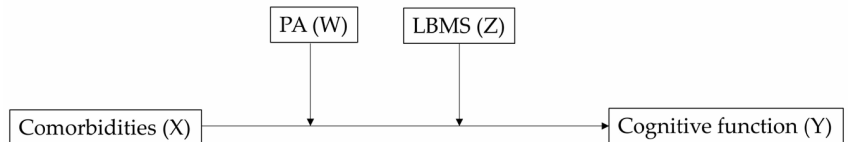
Figure 1. An illustration of the relationship between comorbidities (X) and cognitive function (Y) moderated by physical activity (W) and lower-body muscle strength